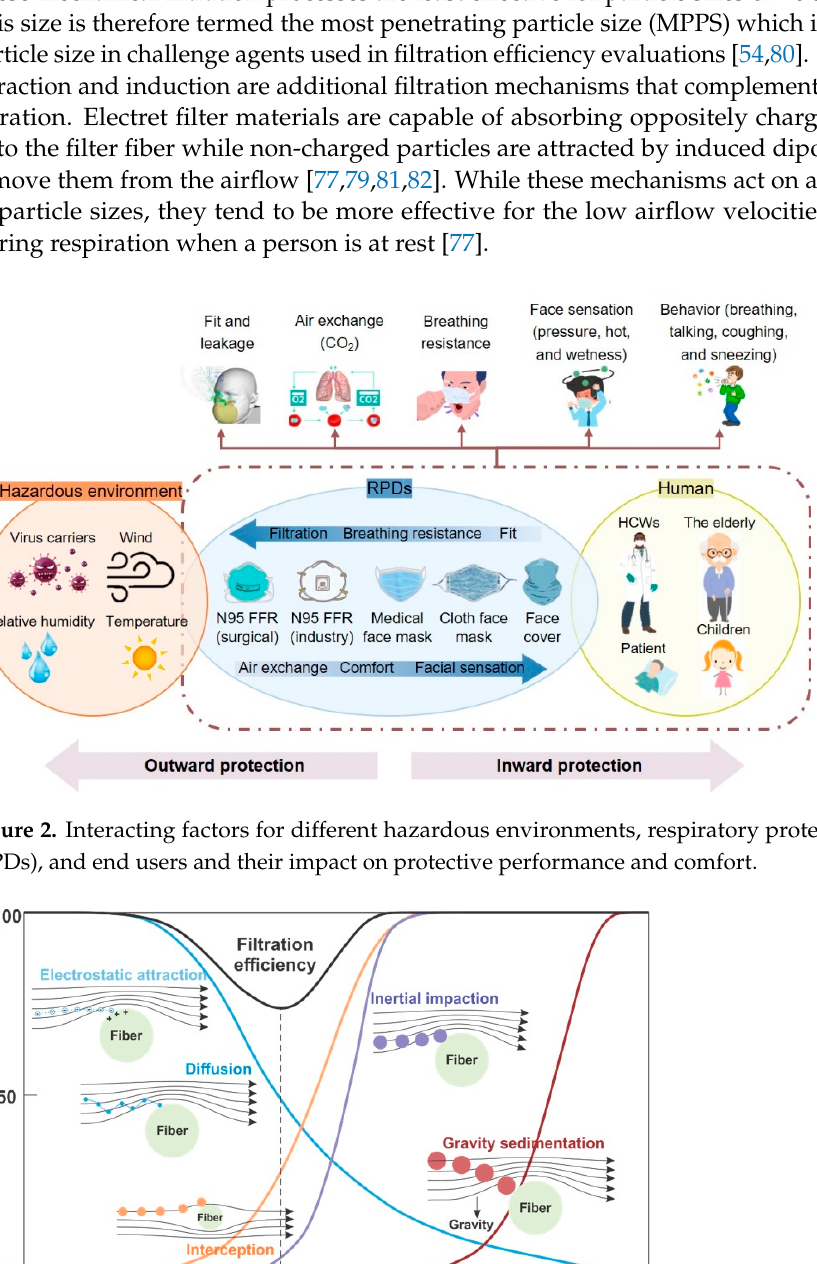
micron size Figure 3. Impacts of particle size and type of filtration mechanism on RPD filtration efficiency.